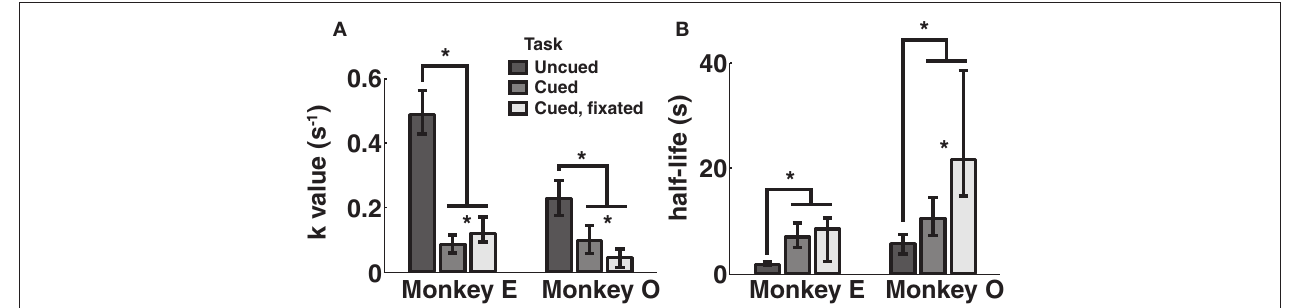
Figure 2 | Discounting rates decrease with explicit information about post-reward delay. Discount parameters were estimated by a maximum likelihood analysis of a hyperbolic model (see Materials and Methods). Error bars represent 95% confidence intervals obtained by bootstrap analysis.